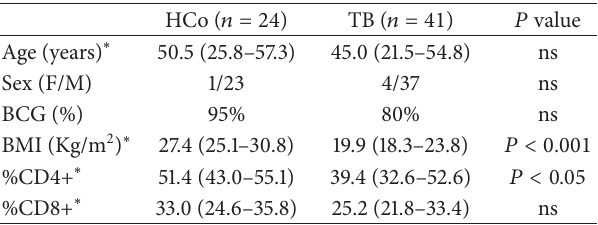
Table 1: Characteristics of study